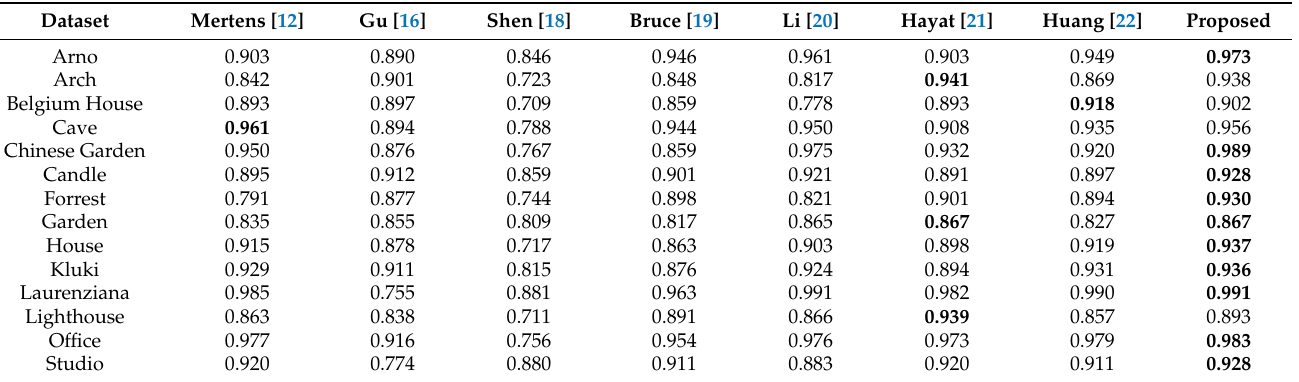
Table 7. The test result of indicator